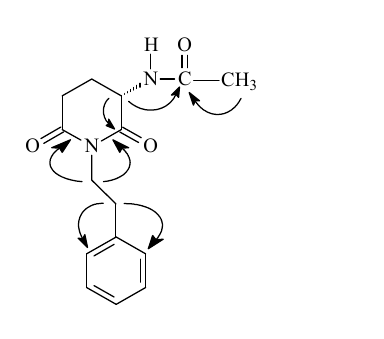
Figure 2. Structure and correlations of the HMBC spectrum of substance 4